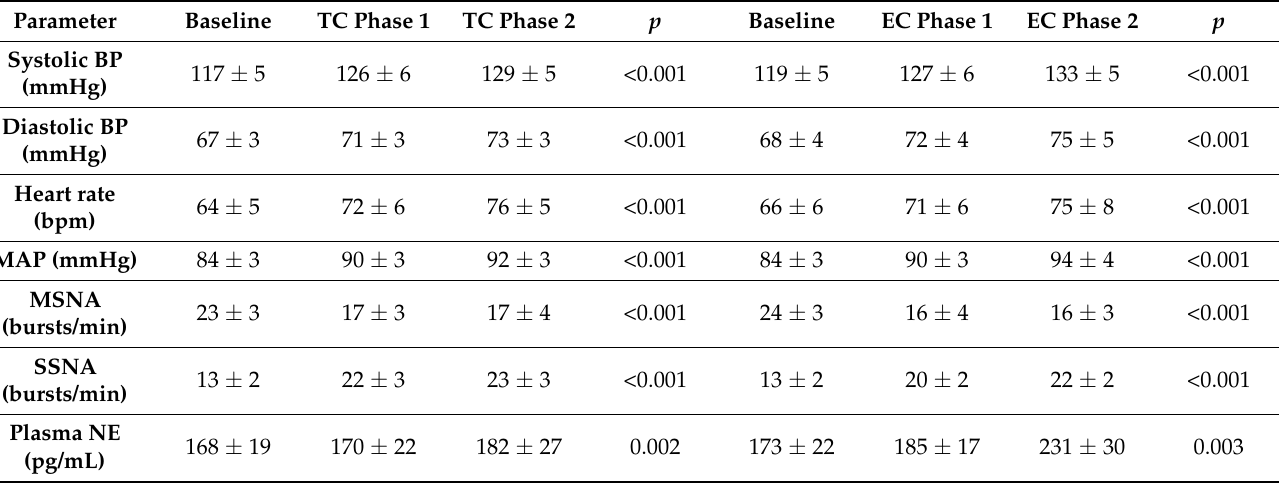
Table 1. Effects of TC and EC smoking on hemodynamic parameters and on sympathetic activity.